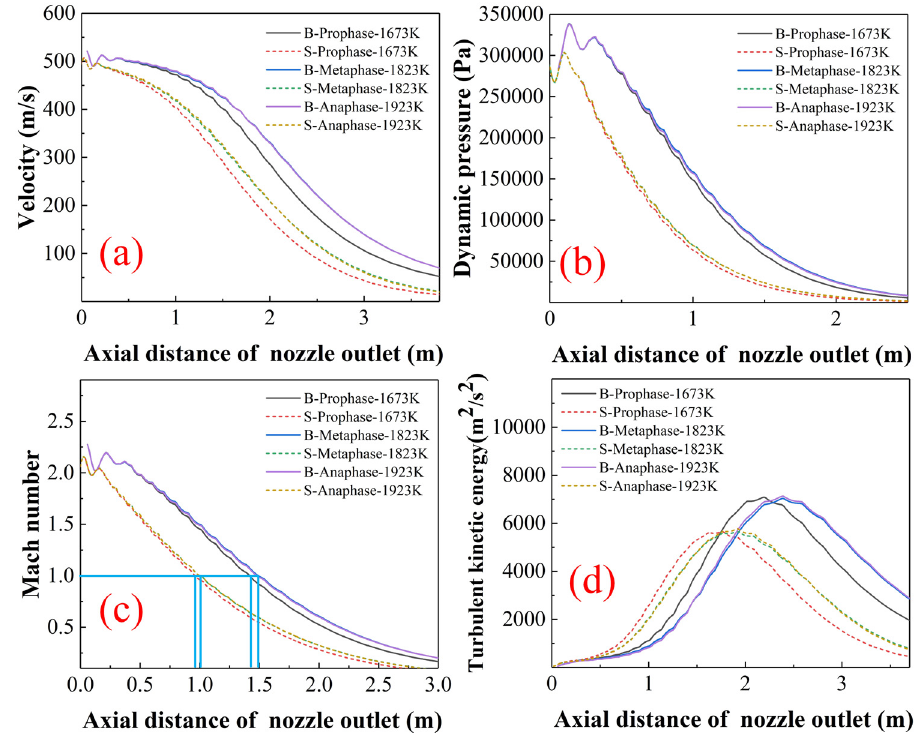
Figure 12: Jet characteristics of the nozzle axis for di ff erent smelting periods: ( a ) velocity, ( b ) dynamic pressure, ( c ) Mach number, and ( d ) turbulent kinetic